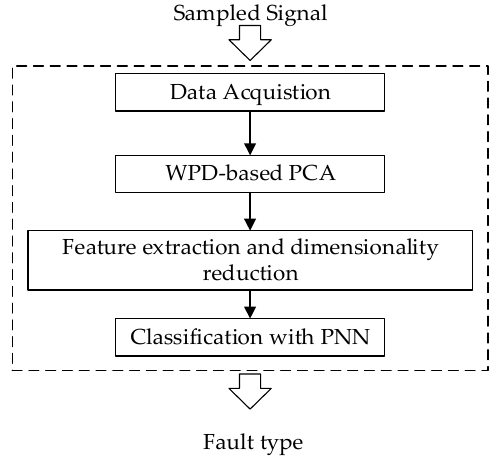
Figure 8. Flowchart of the proposed algorithm.